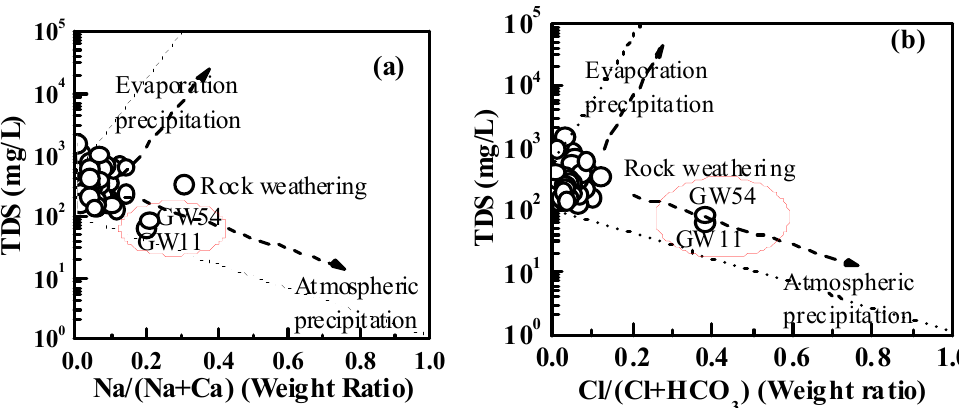
Figure 5. Gibbs diagrams for groundwater samples in the study area, ( a ) TDS versus Na/(Na + Ca), ( b ) TDS versus Cl/(Cl + HCO 3 ).